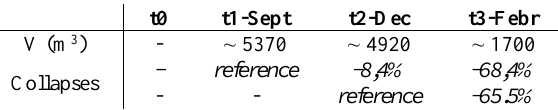
Figure 7. Orthophoto of East wall. Top: September (t1); centre: December (t2); down: January (t3) In Figure 8 a volumetric evaluation on collapsed structures; t1 model, alone (left) and compared to t2 and t3. The collapses caused by seismic shock and consequent loss of structural stability have led to significant loss of volume, up to -68,4% in comparison with the time 1, September 2016.